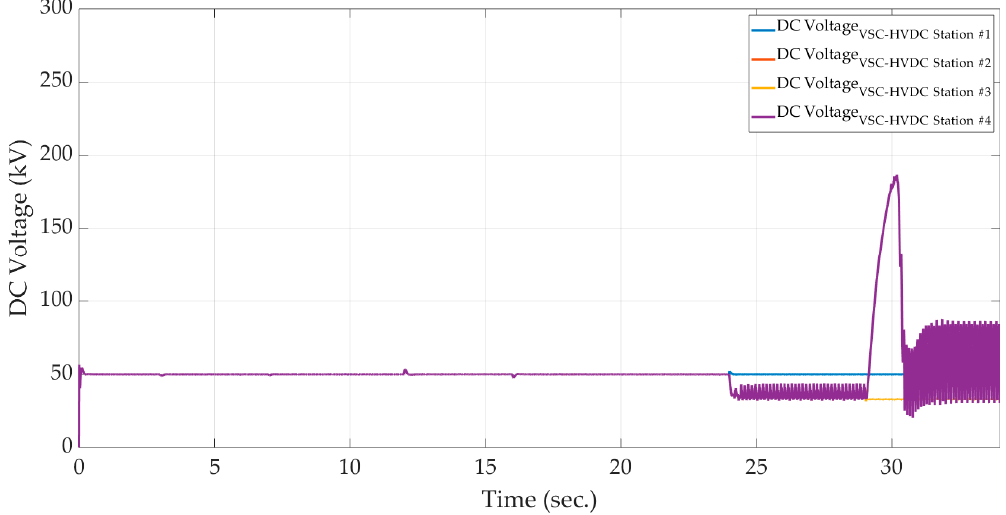
ff erent VSC-HVDC stations in the first scenario. Electronics 2020 , 9 , 87